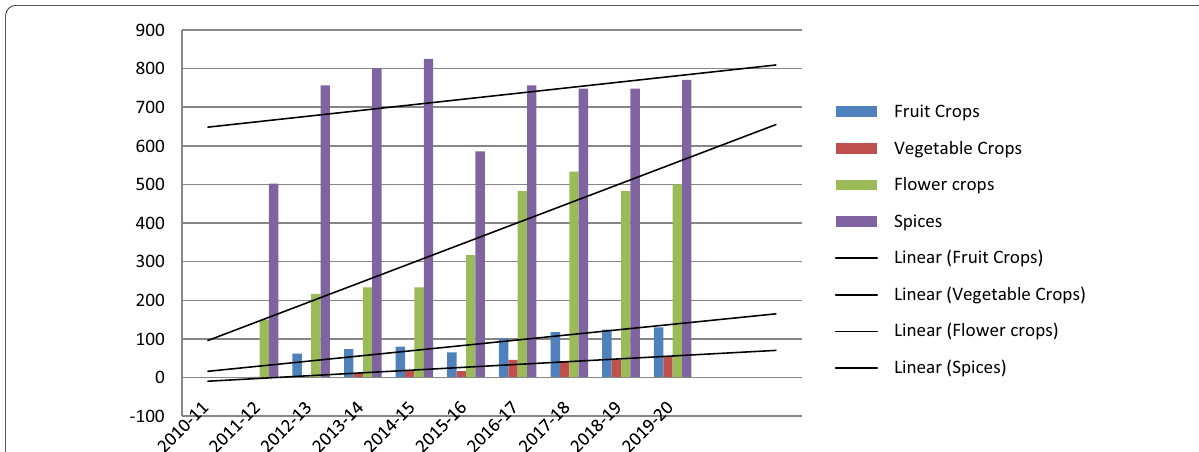
Fig. 16 Per cent growth rate of fruit, vegetable, flower and spices production during 2010–2020 shows an increasing value and its linear forecast also indicates a positive growth trend in Madhya Pradesh